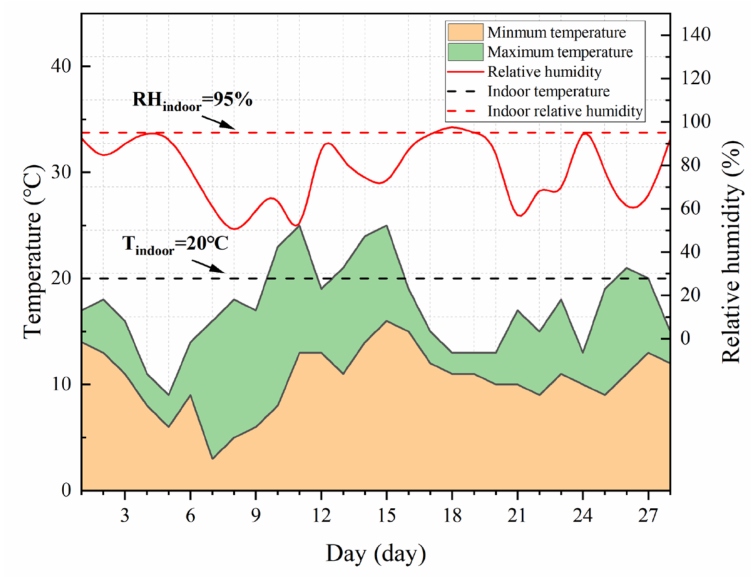
Figure 10. The temperature and relative humidity indoor and outdoor: T indoor is the temperature of the standard curing chamber, RH indoor is the relative humidity of the standard curing